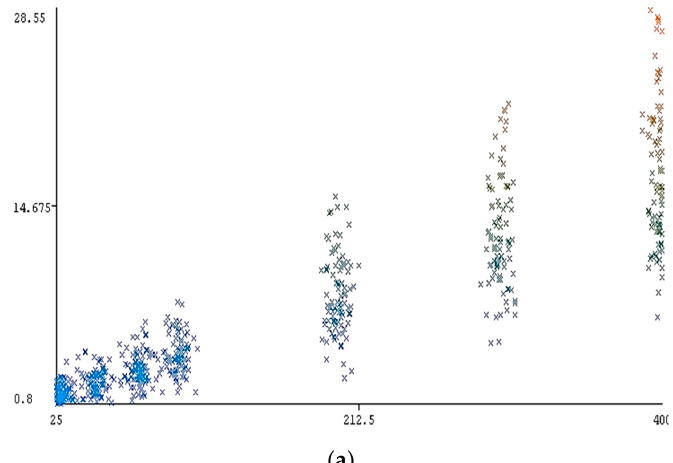
Figure 2. A schematic view of the ( a ) slope geometry and ( b ) the Optum G2 ε xx result, horizontal strain diagram for finite element method (FEM) model with Cu = 75, β = 15, b/B = 1, and w = 50 kPa. The produced dataset was randomly divided into training and testing phases. The training stage consisted of 504 samples (i.e., 80% of the whole dataset) specified to the primary learning process. The remaining 126 samples (i.e., 20% of the whole dataset) were used to evaluate the performance of GPR, MLR, MLP, SLR, and SVR methods (Figure 3). Figure 4 illustrated the scheme of development of the database and selected methodology.